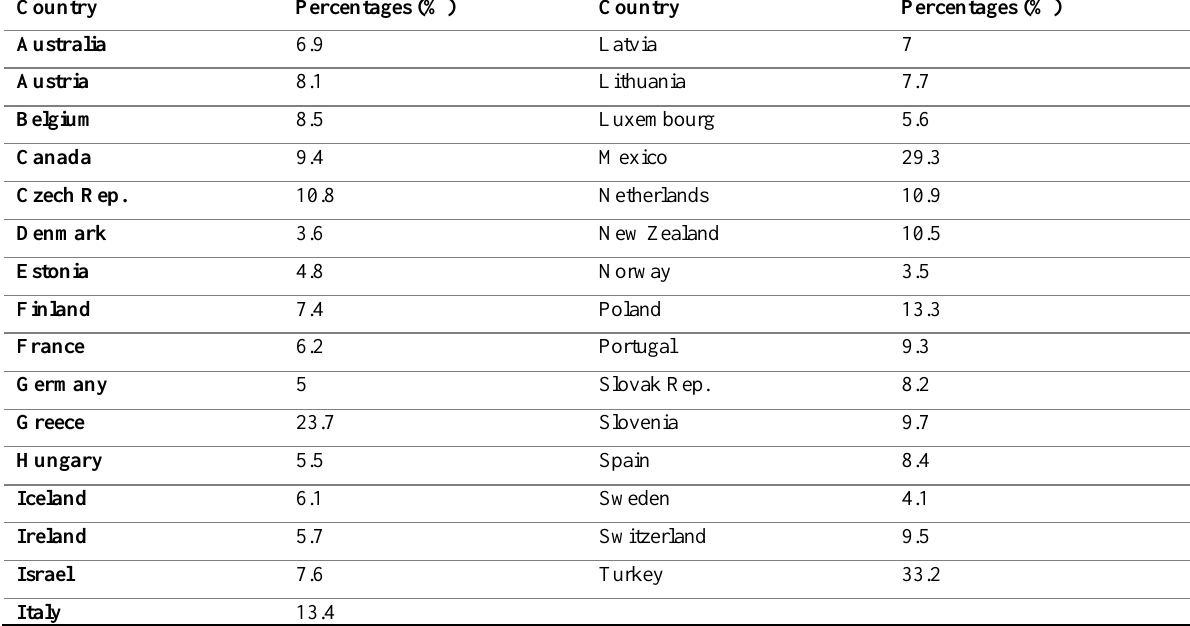
Table 3: Youth neither employed nor in education nor training